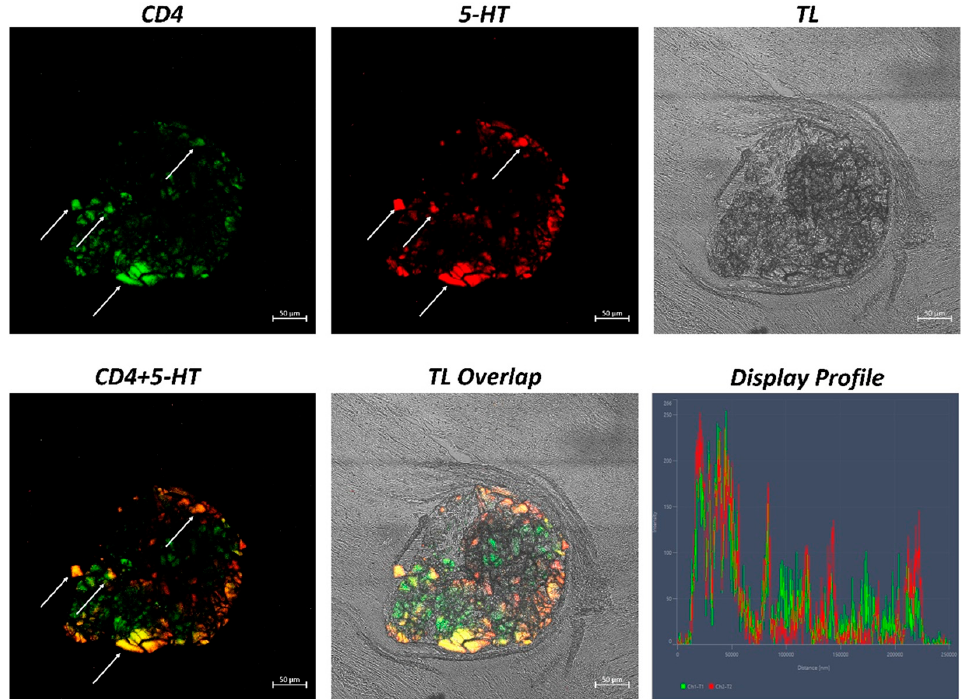
Figure 3. Section of the H. niloticus gut (immunofluorescence, 40 × , scale bar 50 µ m. The presence of an important accumulation of densely packed lymphocytes is highlighted by CD4 and 5-HT positivity (arrows). The “Display profile” function highlights the colocalization. TL = transmitted light.